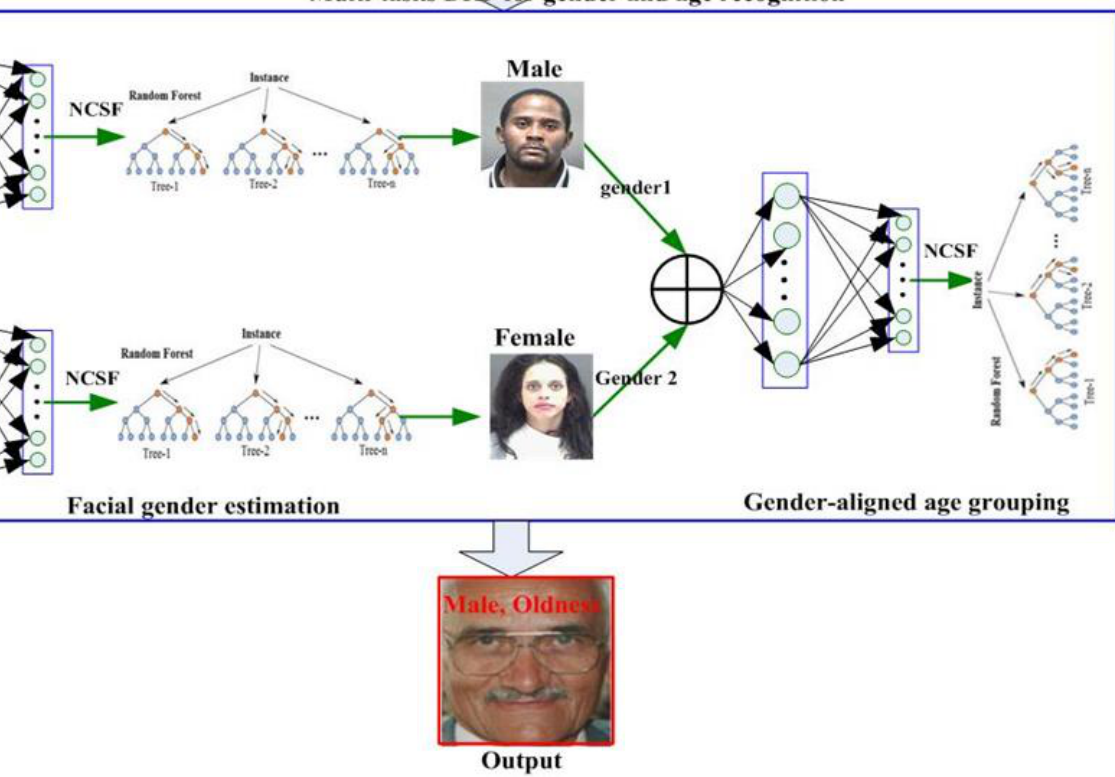
Figure 1. An overview of the proposed method for facial gender and age classification.